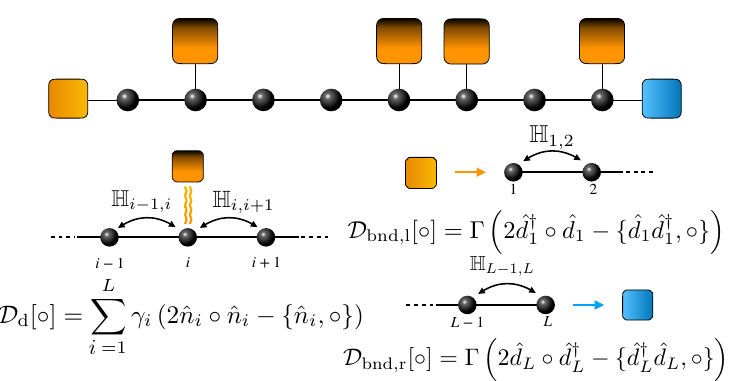
Figure 1: (Top) Cartoon of the Anderson or AAH models randomly coupled to Markovian dephasing baths (MDB). Each black bullet represents a site on the lattice and the red squares above the chain depict the local baths. The absence of some squares illustrates the fact that the coupling to the baths is controlled by the random variable γ probability p . The left and right boundary terms inject / absorb particles from the system. (Bottom) The details of the local couplings on site i . operators in the bulk and at the